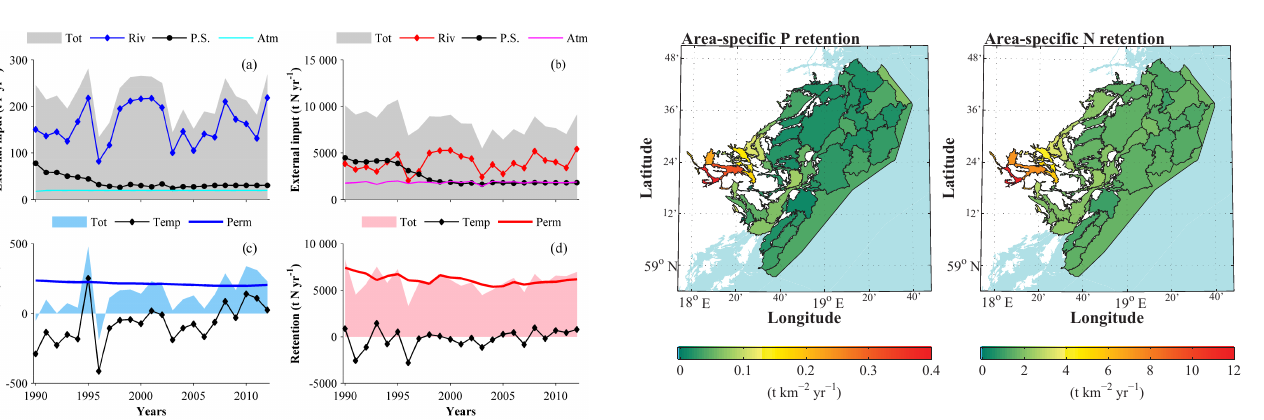
Figure 10. The external annual load and retention (tyr − 1 ) of P (a, c) and N (b, d) in the entire Stockholm Archipelago for the period 1990–2012. Total load (shaded area) and the contributions from the different sources – rivers and land runoff (diamonds), point sources (circles) and atmosphere (solid line) – are shown in the top row. The total retention (shaded area) as a sum of permanent retention (solid line) and temporary retention (diamonds; c , d ) is shown in the bottom row.